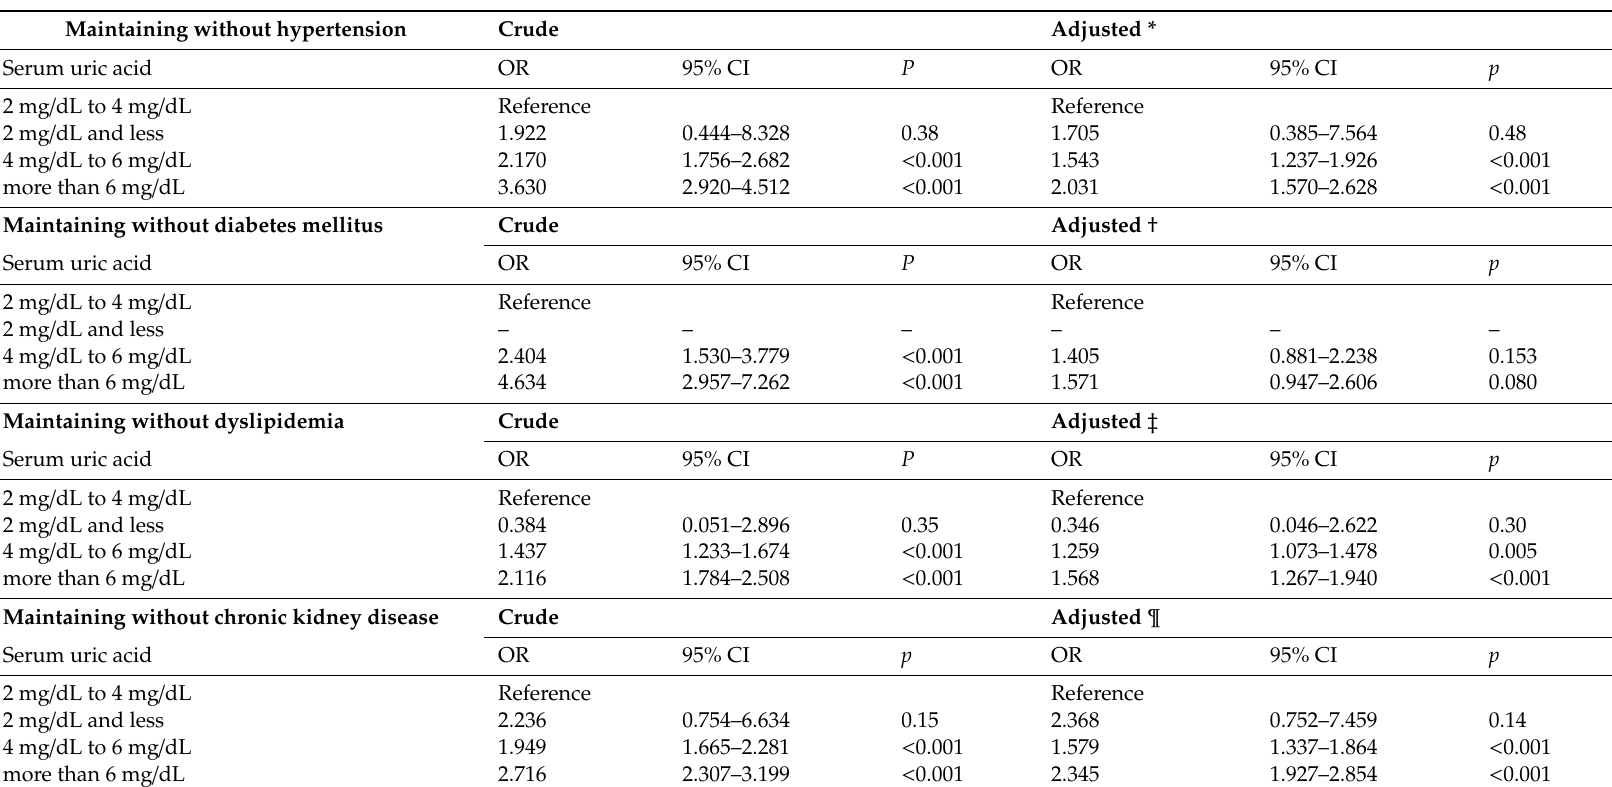
Table 3. Lower serum urate as a protective factor for the development of hypertension, diabetes, dyslipidemia and chronic